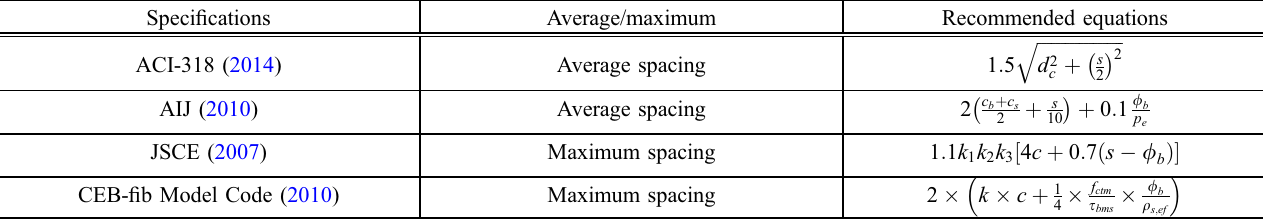
Table 3 Various specifications for the average flexural crack